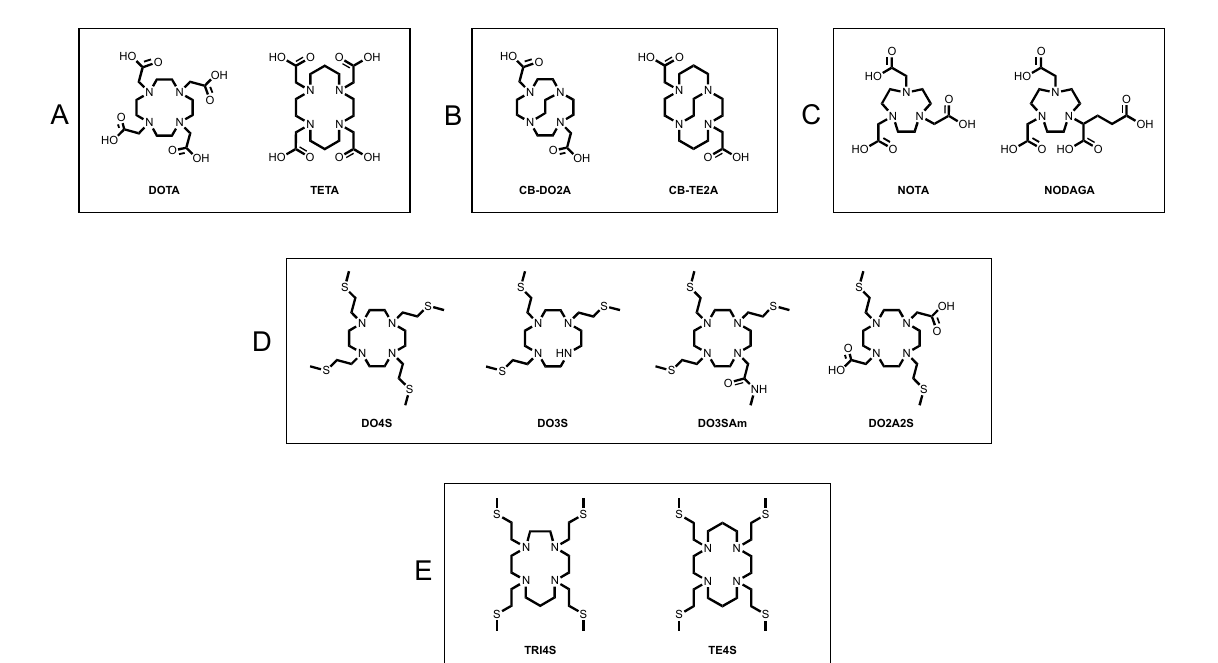
Figure 1. Structure of ( A , B , C ) state-of-the-art ligands for [ 64 Cu]Cu 2+ chelation, ( D ) cyclen-based sulfur-containing ligands and ( E ) non-cyclen-based sulfur-containing ligands.